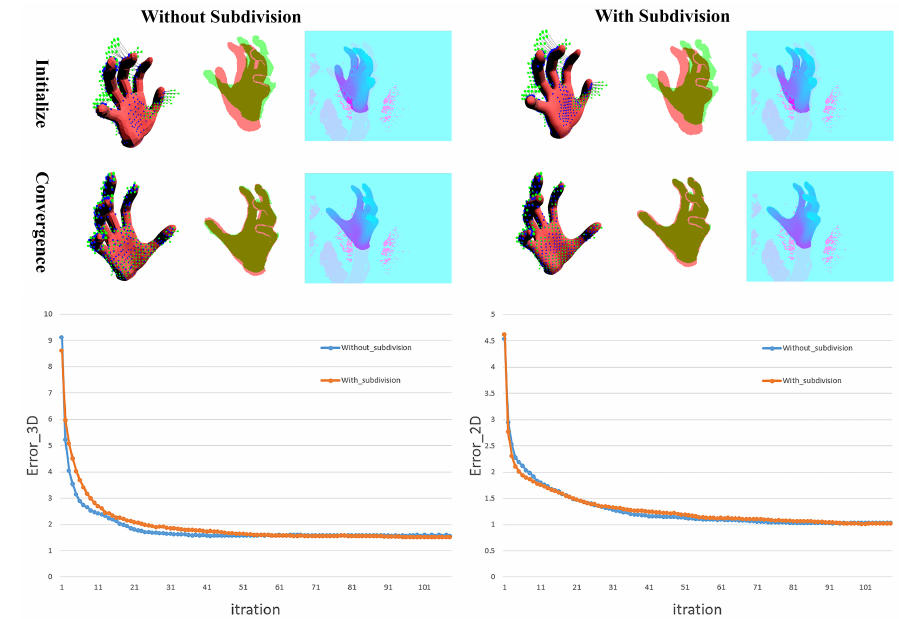
Figure 9. The comparison of two different corresponding points finding ways when we fit an input image from the Handy/Teaser data-set [5]. Each part from left to right is the 3D image, mixed 2D silhouette, and mixed depth image applied pseudo-color enhancement. The 3D image contains point cloud X s in green, hand model in red, and corresponding points on the hand model in blue. The red part in the mixed 2D silhouette is the rendered silhouette of the hand model, while the green part is the silhouette of input. The mixed depth shows how the rendered depth matches the original depth map, using pseudo-color enhancement for better viewing. The Error 3 D and Error 2 D are the metrics mentioned in Section